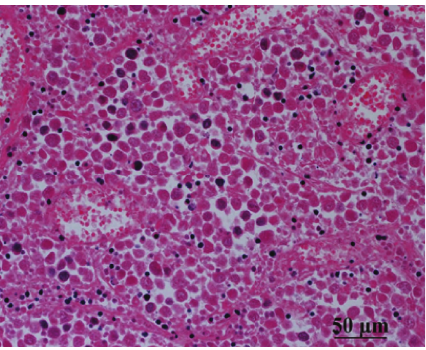
Figure 3: Left testis section (hematoxylin-eosin stain). Area was dominated by necrotic tissue, but some cells showed high nuclear/cytoplasmic ratios, suggestive of